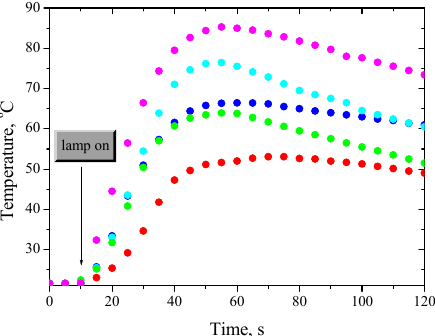
Figure 1. Comparison of temperature changes during irradiation of monomer composites contain- ing synthesized photoinitiators and commercial camphorquinone. Photoinitiating systems include:  –Ph1 (dibenzo[a,c]phenazine),  –Ph2 (benzo[a]phenazine),  –Ph3 (11 H -indeno[1,2-b]quinoxalin- 11-one),  –Ph4 (6 H -indolo[2,3-b]quinoxaline) and  –CQ (camphorquinone) as photoinitiator, and 1-naphthoxyacetic acid (NAA; c = 0.1 M) as co-initiator. I = 15 mW/cm 2 .